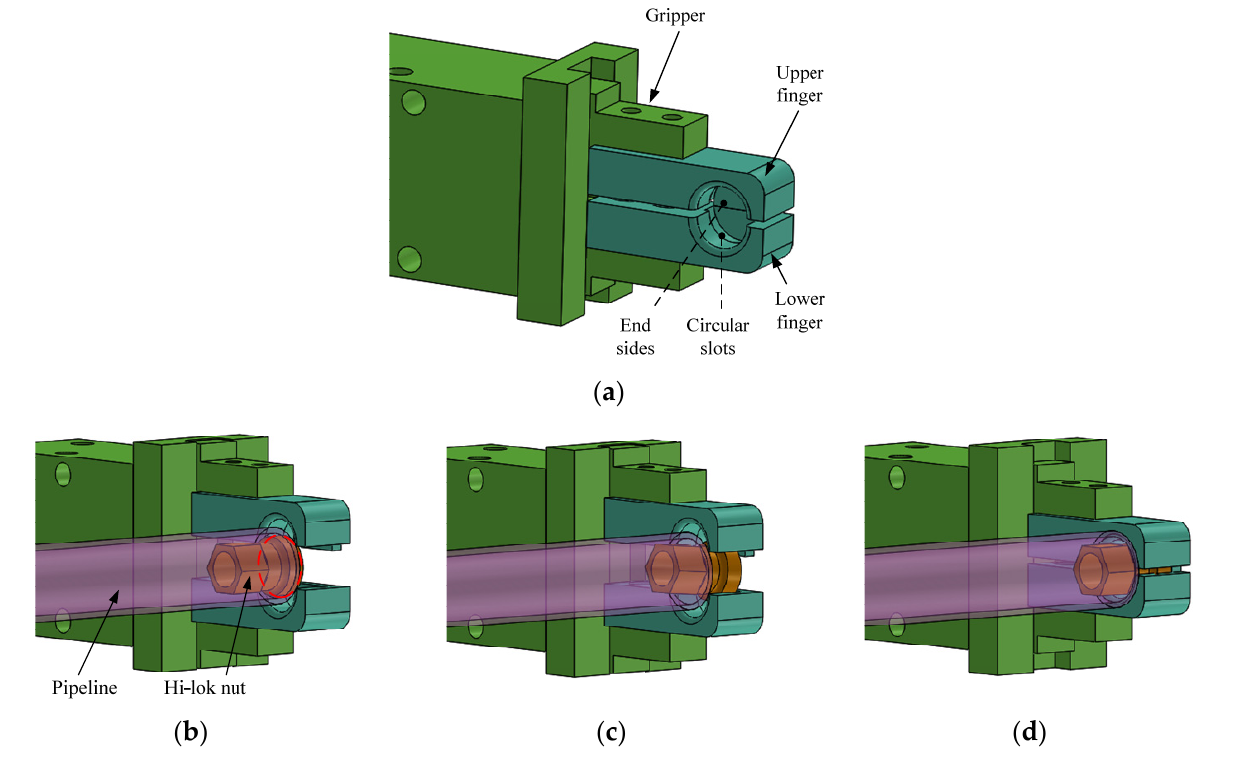
Figure 7. Structure and working principle of pneumatic gripper, ( a ) gripper structure ( b ) fingers open, nut passes ( c ) nut entering into circular slots ( d ) fingers close, clamping nut.